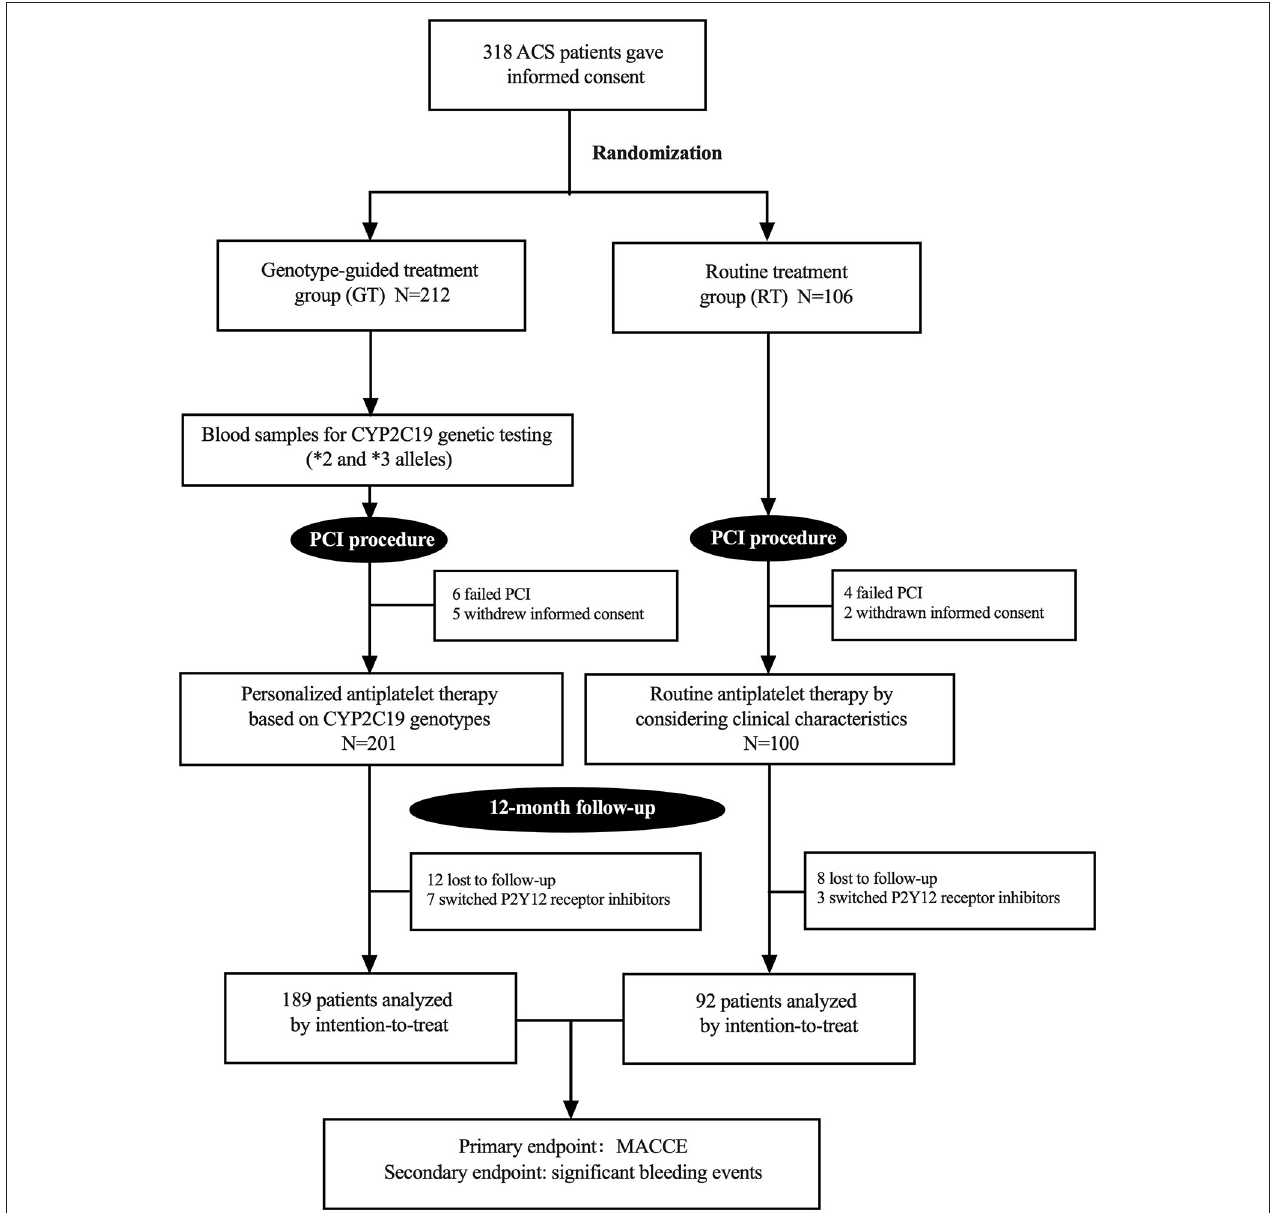
FIGURE 1 | Study flow chart. ACS, acute coronary syndrome; PCI, percutaneous coronary intervention; MACCE, major adverse cardiovascular or cerebrovascular events.